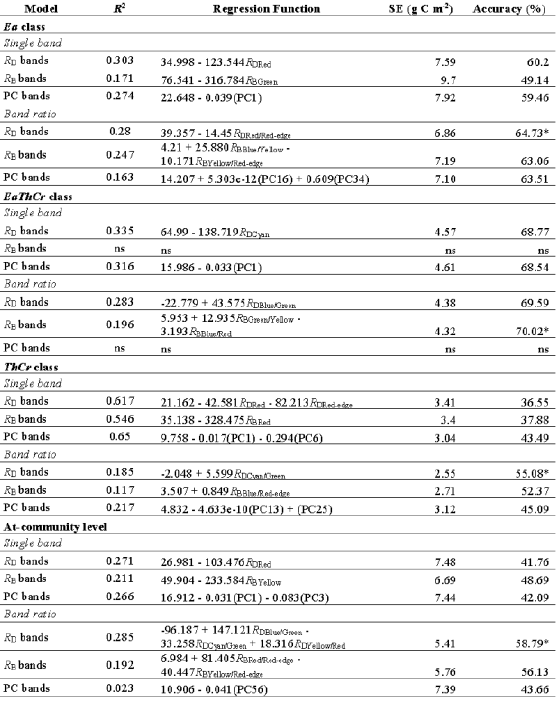
Table 4 . Accuracy assessment results of the AGC seagrass